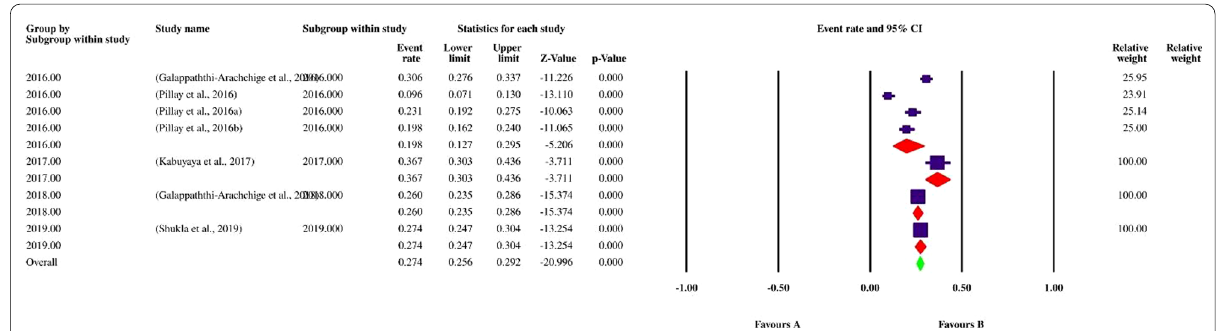
Fig. 5 Forest plot of year-based prevalence in South Africa (2016–2020)